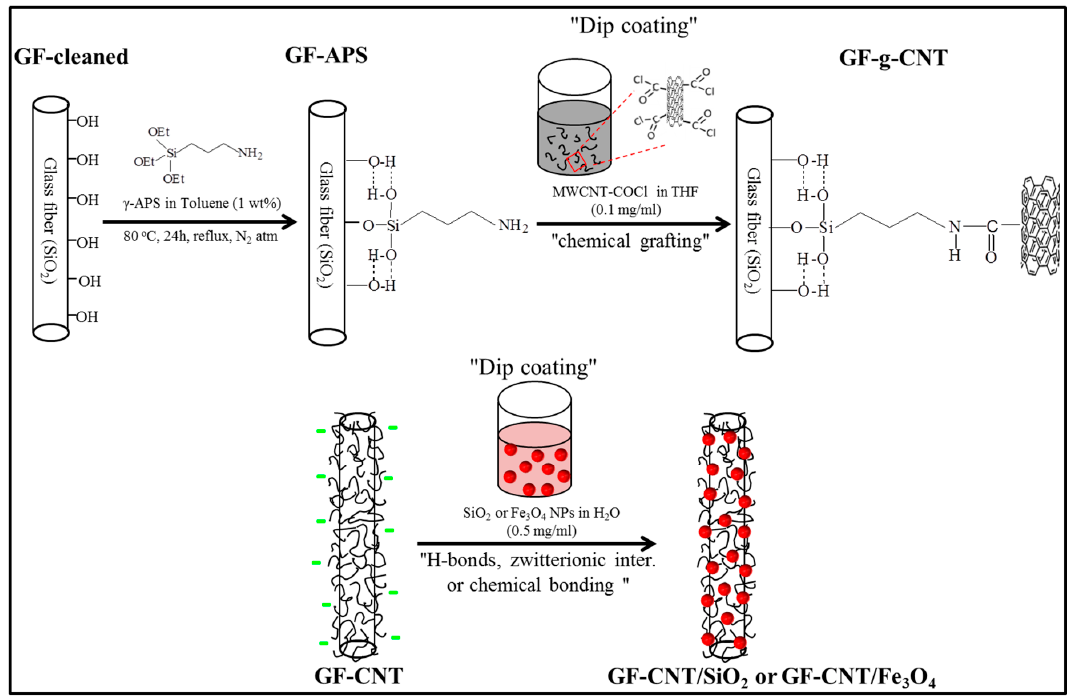
Figure 1. Schematic illustration of the wet chemical process to graft MWCNTs onto the surface of GFs, as well as decoration with positively charged SiO 2 or Fe 3 O 4 NPs, respectively. A dip coating deposition process was used in both